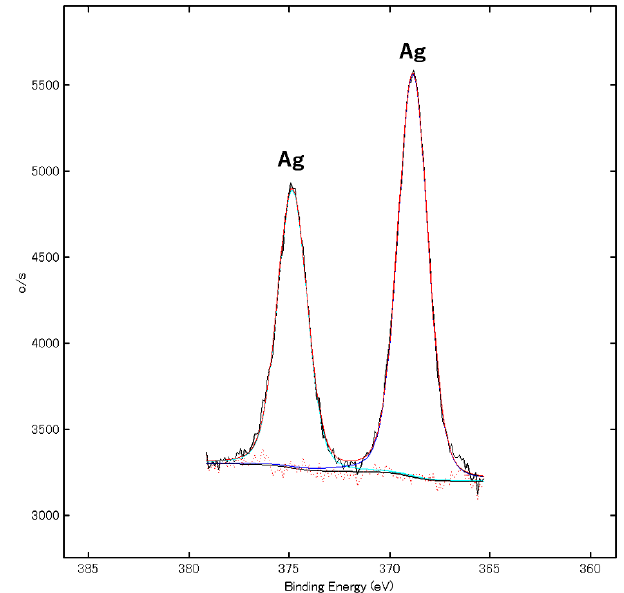
Fig. 4. HRXPS spectra of Ag 3d of p(AMPS-Na + - co Fig. 4 HRXPS spectra of Ag 3d of p(AMPS-Na + -co-VIm)-Ag